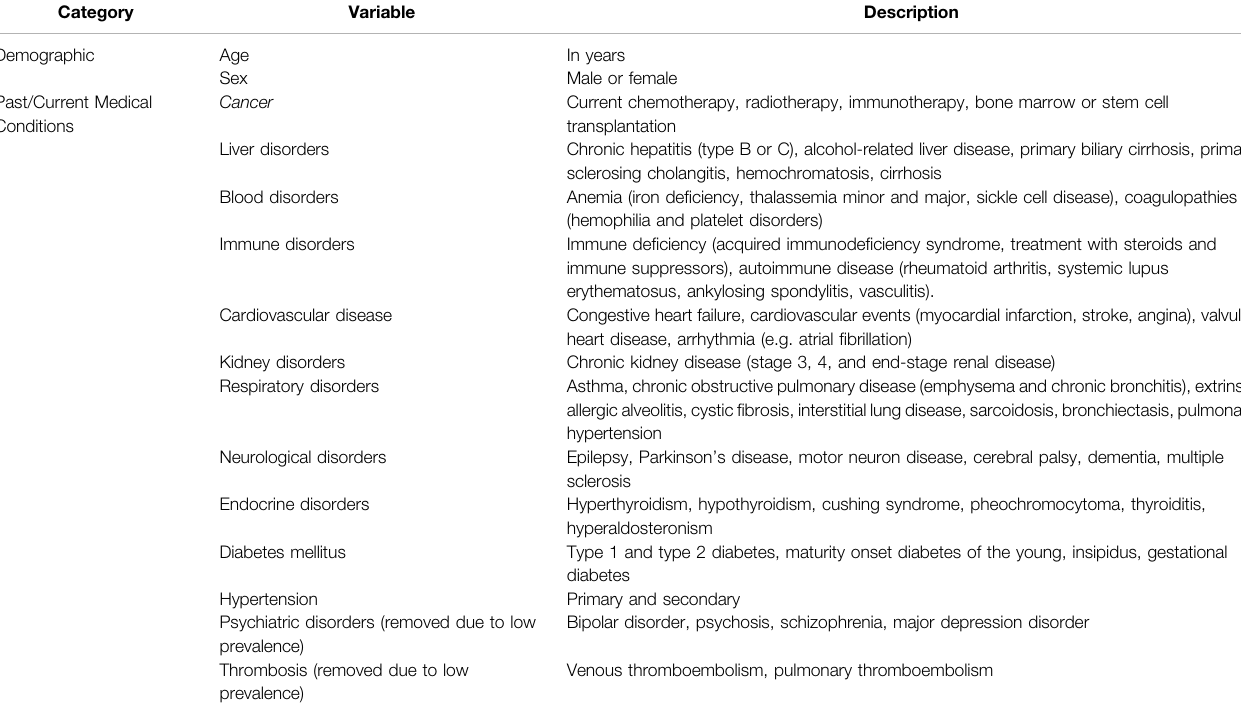
TABLE 1 | List of predictors . Predictor variables for mortality risk and symptom prediction of COVID-19.